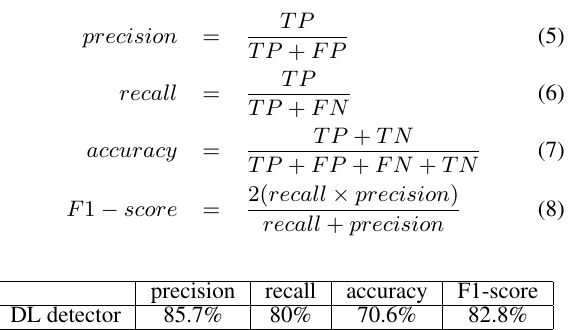
Table 2. Waste deep-learning detector.